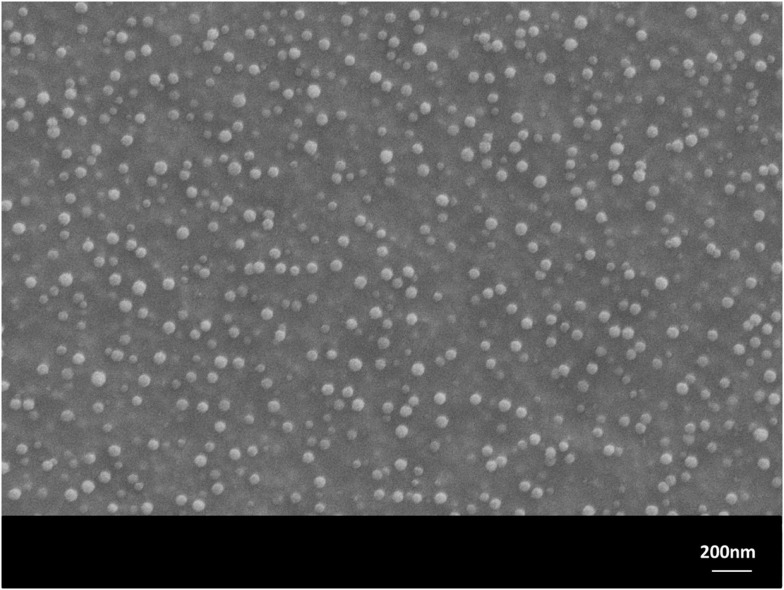
Microstructure of glass No. 2 after 1 h heat treatment at 600°C. Sr5(PO4)3F (with minor NaSrPO4) spherical crystals of nanometer size are visible. Monolithic sample, polished surface, HF etched. SEM.